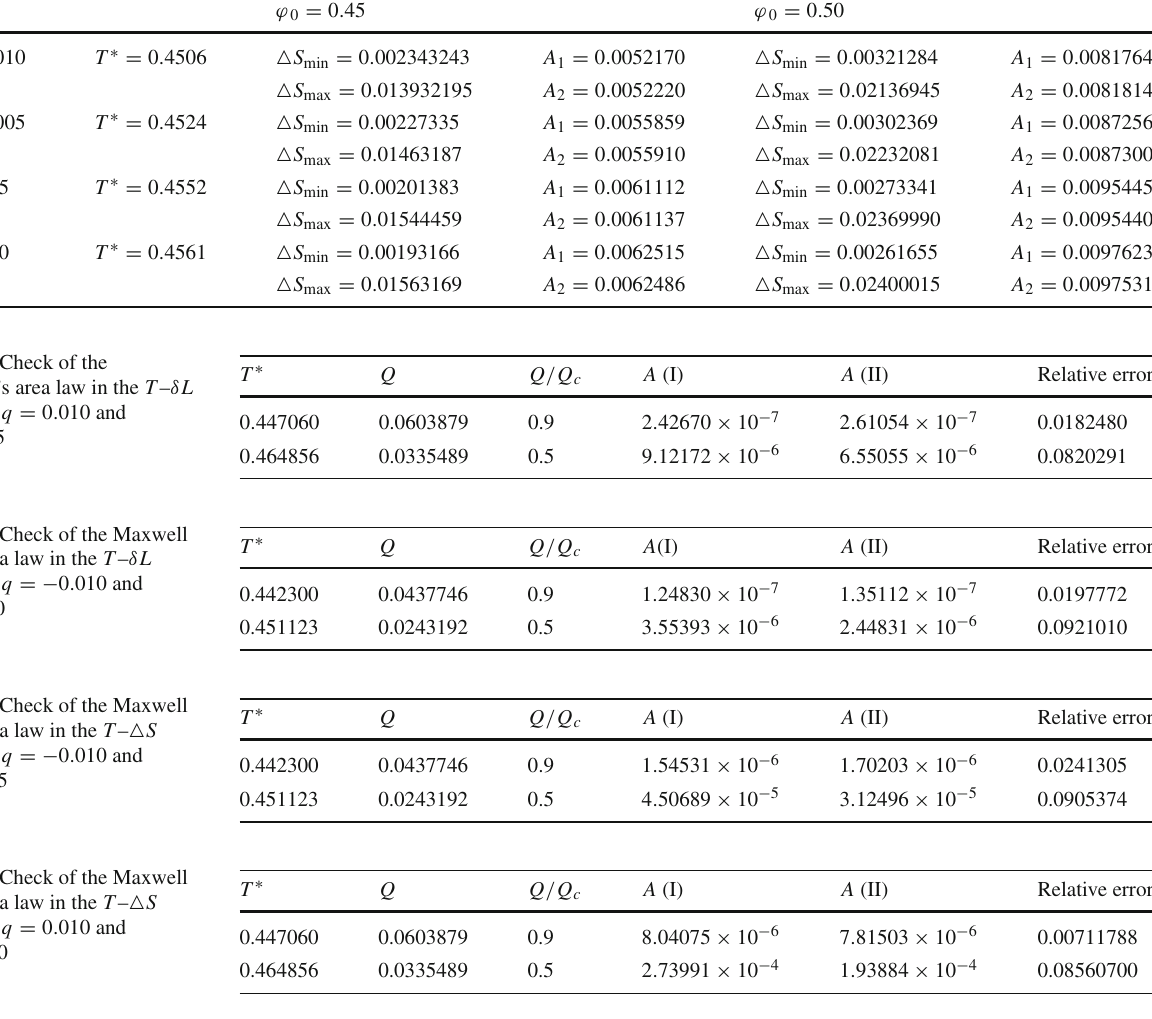
Table 8 Check of the Maxwell equal-area law in the T – (cid:8) S plane for q = 0 . 010 and ϕ = 0 . 0